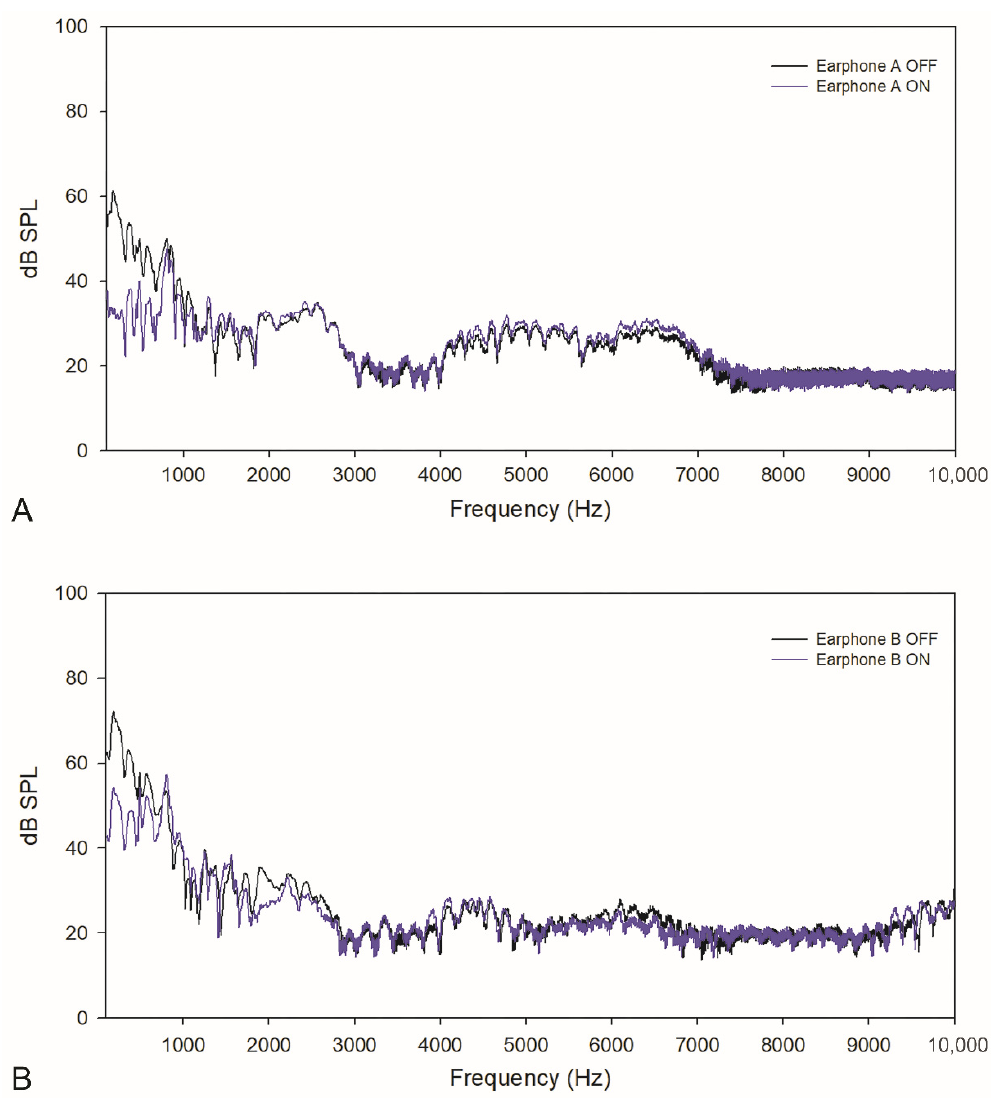
Figure 2. Acoustic characteristics of café noise in earphones ( A , B ). 4. Discussion The current study explores how the NC function works in different types of ear- phones as well as how it impacts PLLs in the presence of café and bus noises. Findings of the study showed that when the NC function is activated in café and bus noises, SPLs of the sound signals were significantly reduced for all types of earphones in the low-fre- quency range. Similar results were obtained for PLLs: for earphone A and B, which were wireless and wired canal type earphones, PLLs were also significantly decreased with the NC function on. The authors believe that these results were obtained because earphone A and B had rubber tips that could seal the opening of the ear canal. This is consistent with a previous study in 2011 that reported that the structure of the earphone could influence the PLLs and the amount of sound signals coming into the ear canal [14]. In this study, the authors performed REMs utilizing three types of earphones (earbud, ear canal, and on-the-ear earphone) to measure PLLs in quiet and noise for 25 adults. In quiet, the ear canal earphone had the lowest PLLs (60.3 ± 12.9 dB SPL). In noise, the on-the-ear earphone had the largest PLLs (77.5 ± 11.2 dB SPL). The authors mentioned that sealing the ear canal would prevent noise coming into the ear canal. This leads to better signal-to-noise ratio, and therefore, listeners could easily enjoy music at a lower volume [14]. Another factor that could have influenced the PLLs was loud noise [4,9,15]. Williams (2005) reported that